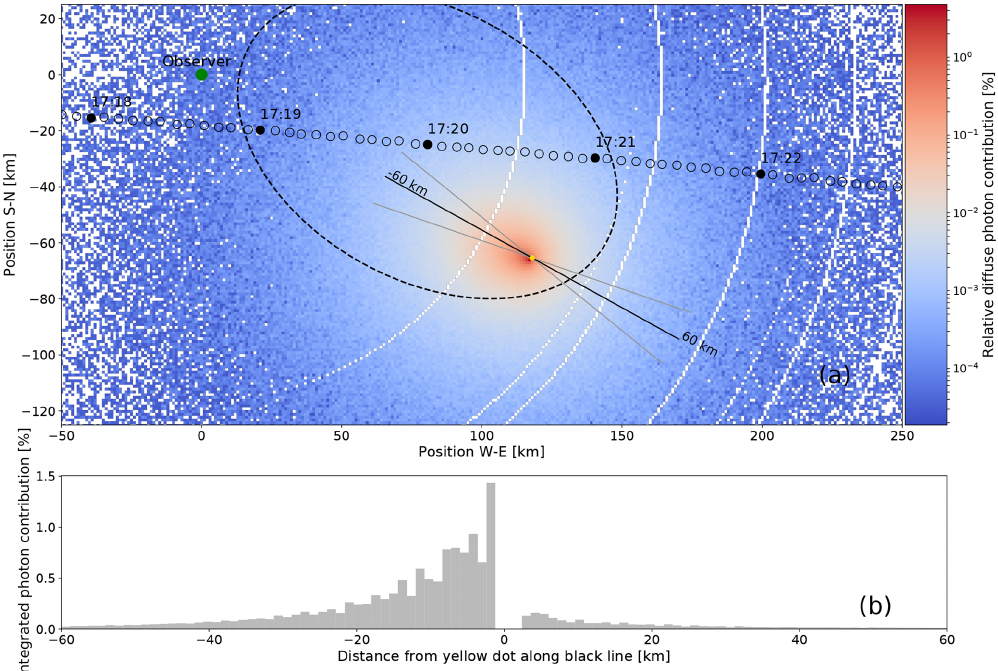
Figure 7. Panel (a) illustrates the relative contribution from each point in the sampling plane to diffuse irradiance. Shown is a 150 × 300km cutout of the contribution function at 17:20:00UTC and 490nm wavelength. The green dot is located directly above the observer, the yellow dot marks the origin of the direct solar radiation (compare to Fig. 1). Small black circles indicate the center of the lunar shadow on its way from west to east in 5s steps with times annotated every minute. The dashed ellipse represents the shape of the umbral shadow at 17:20:00UTC. Panel (b) shows the contribution function along the black line, integrated within the area bounded by the two gray lines as histogram. The white circles visible in panel (a) are an artifact from the projection of the spherical grid of the simulation to the flat sampling plane.